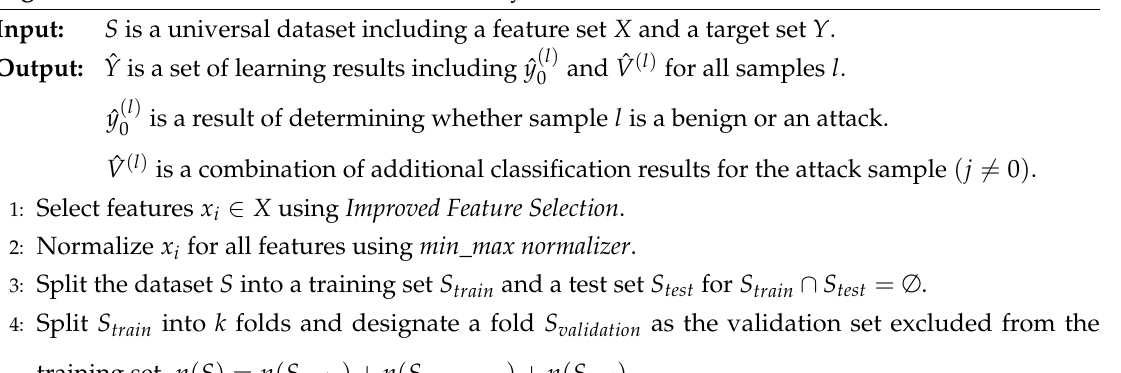
Algorithm 1 Multi-labeled hierarchical anomaly